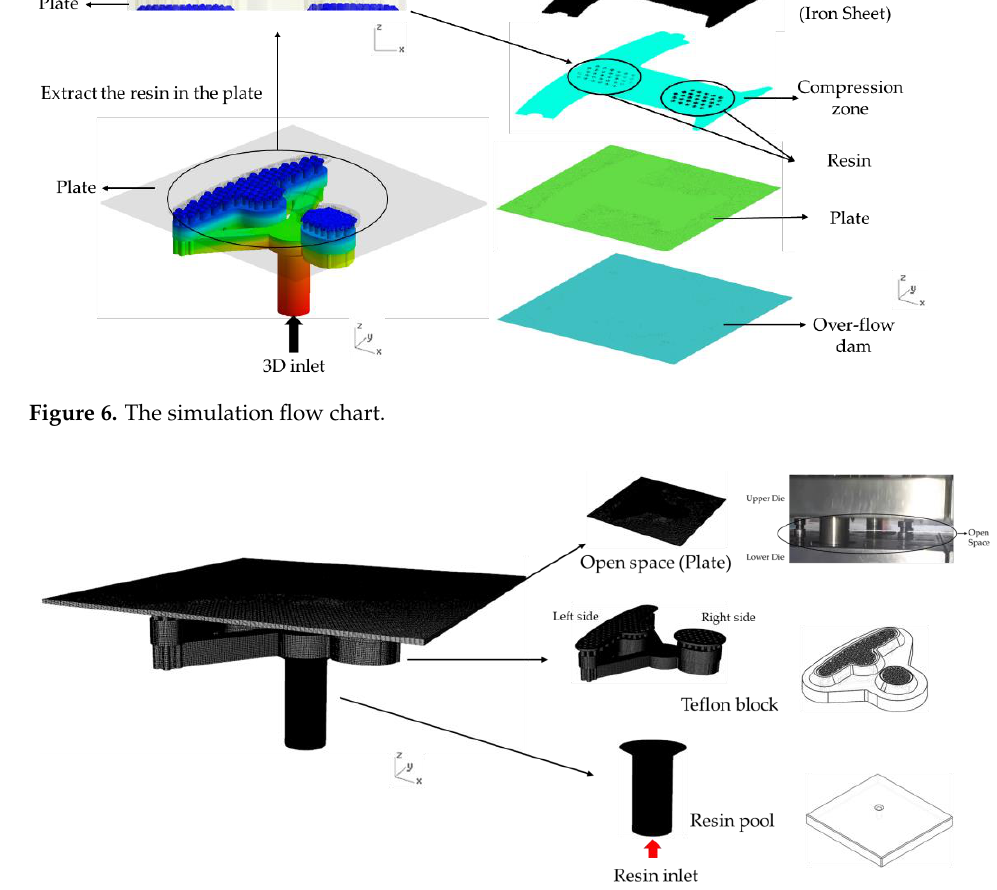
Figure 7. Mesh model used in the filling process.